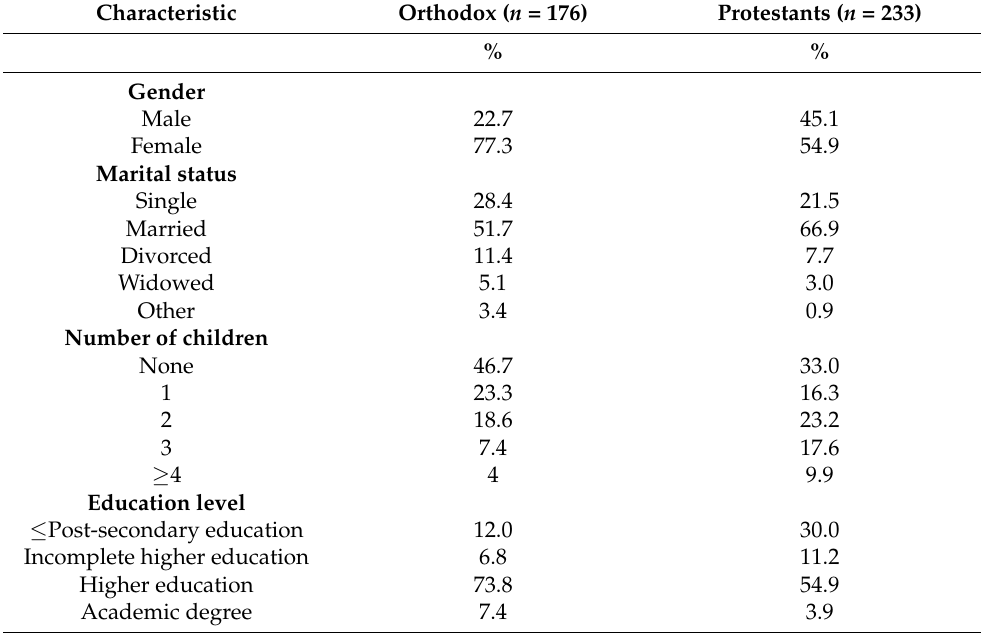
Table 6. Participant characteristics ( n =